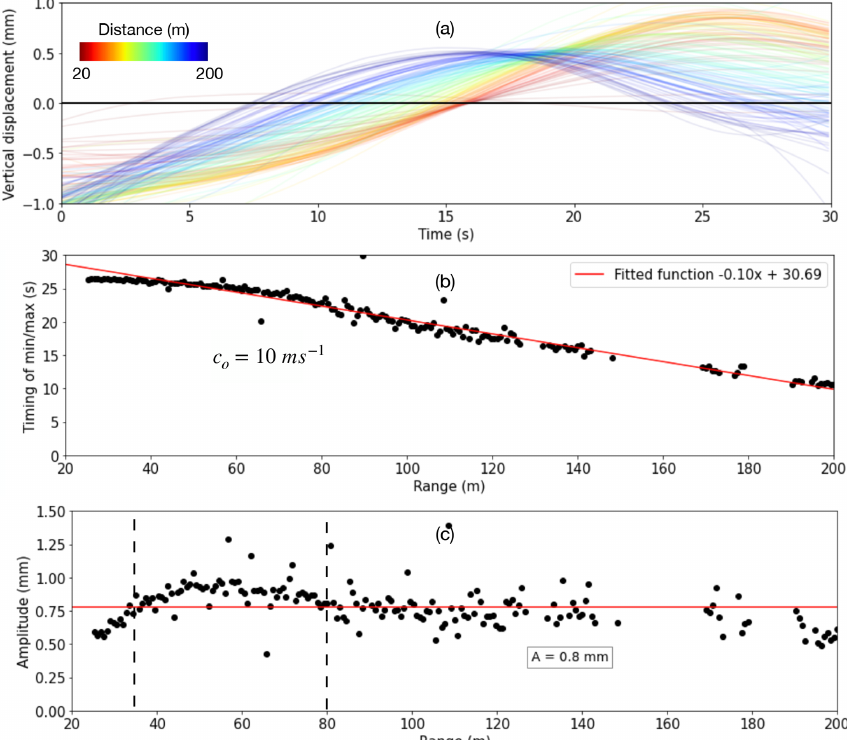
Figure 6. (a) Derived vertical displacement over 30s on 23 April 2021 at 21:56UTC (E1). Each line represents one location on the ice, where warmer colors signify a distance closer to the radar. (b) Exact time of the wave crest at different distances from the radar. The linear fit indicates a wave velocity of 10.0ms − 1 . (c) Amplitude with